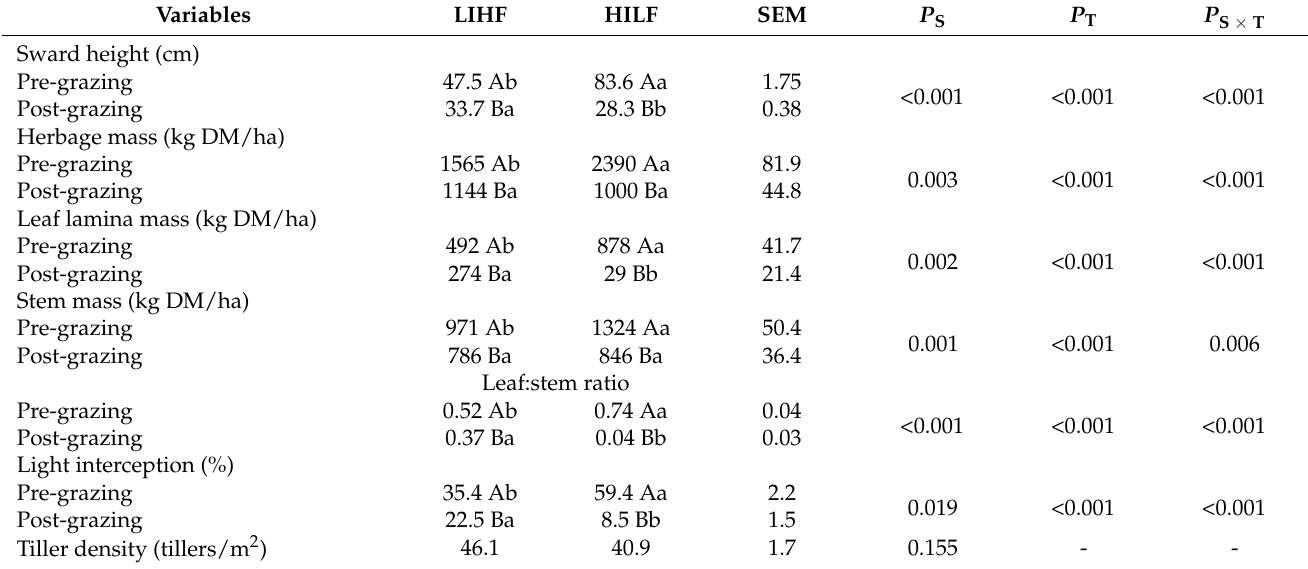
Table 1. Characteristics of sorghum pastures grazed by beef cattle under different grazing manage- ment strategies (LIHF and